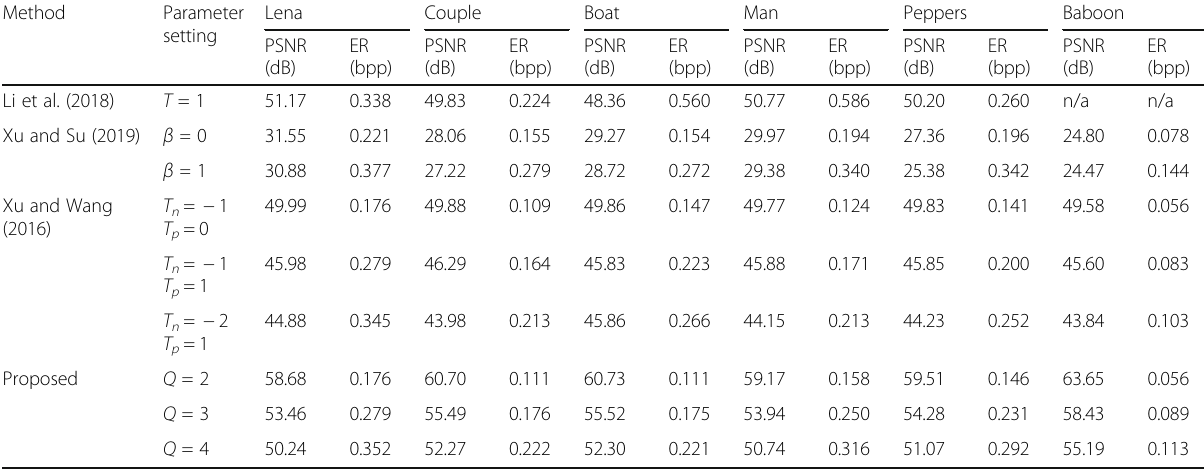
Table 3 Comparison among four methods in terms of PSNR and maximum ER Method Parameter